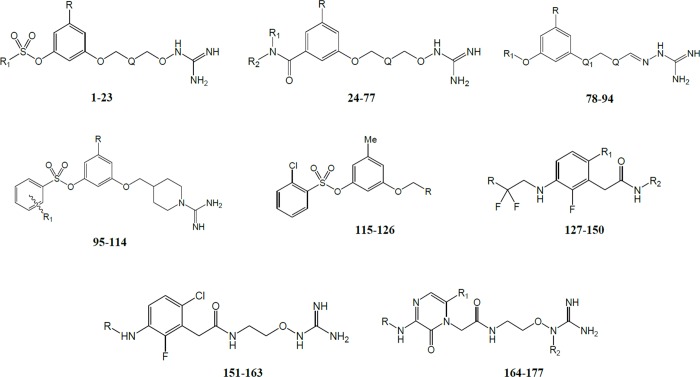
Structures of TIs.